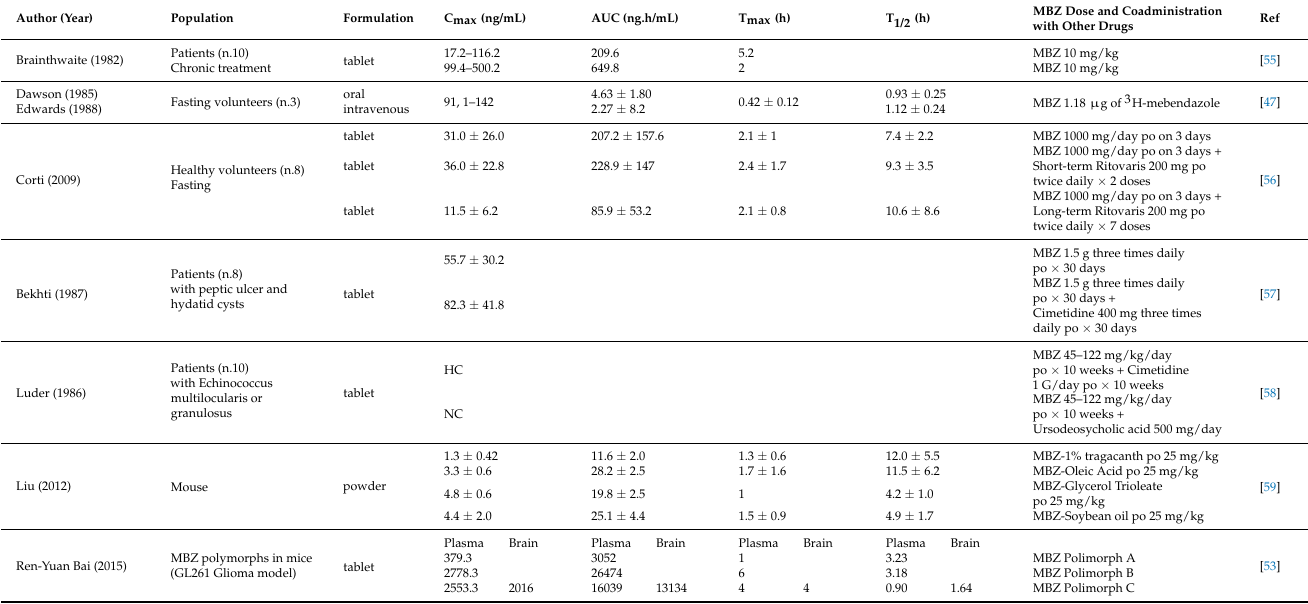
Table 2. Mean pharmacokinetic parameters of MBZ extracted from different